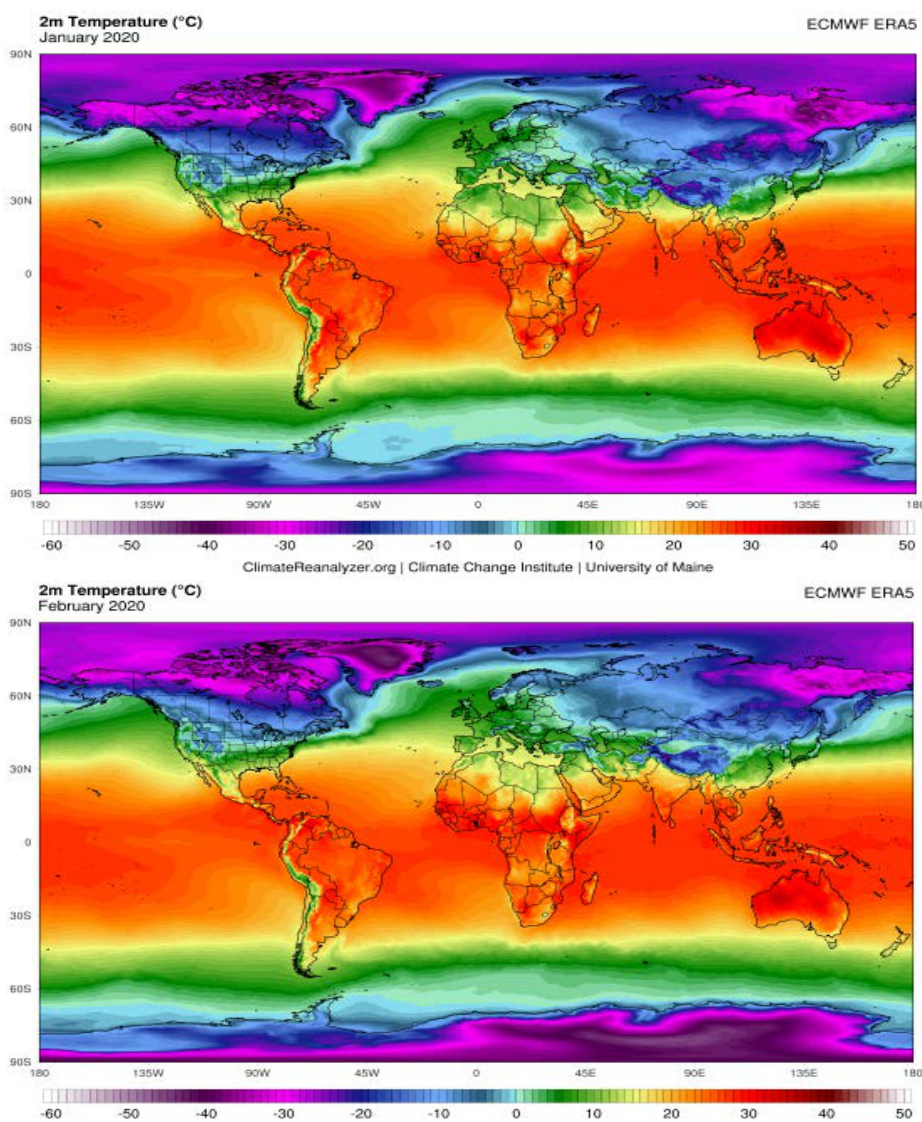
Figure 5. Monthly temperature (degree C) reanalysis maps using ECMWF dataset of all the world. The temperatures at 2-m height, obtained from ERA-interim datasets (https://climatereanalyzer.org/), have been processed to extract monthly means maps for the period November 2019 to February 2020. ERA-interim is a global reanalysis of recorded climate observations over the past 3.5 decades. It is presented as a gridded data set at approximately 0.7 degrees spatial resolution and 37 atmospheric levels. ERA-interim is produced by the European Center for Medium-Range Weather Forecasts (ECMWF) (https://climatereanalyzer.org/).